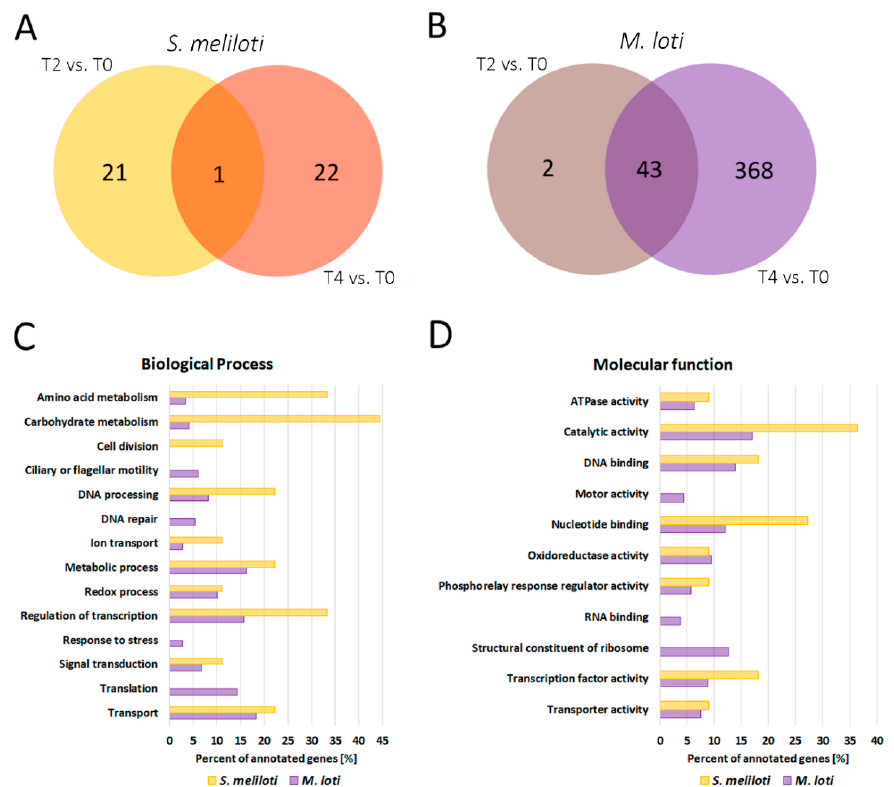
Figure 5. The number of S. meliloti ( A ) and M. loti ( B ) genes differentially expressed in root nodules during two- (T2) and four-day long (T4) drought stress in comparison to the control plants not exposed to water deprivation (T0). The categorisation of differentially expressed genes in drought-stressed (both T2 and T4) bacteroids, in comparison to well-watered controls for S. meliloti (44 genes) and M. loti (413 genes), based on biological processes ( C ) and molecular functions ( D ).